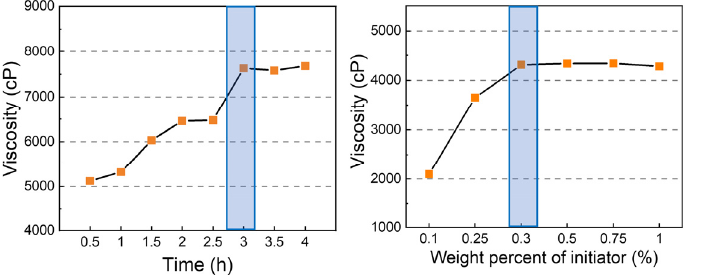
Figure 3. The relationship between the reaction time and viscosity of the FVMQs ( left ) and the relationship between the weight percentage of the initiator and viscosity ( right ).